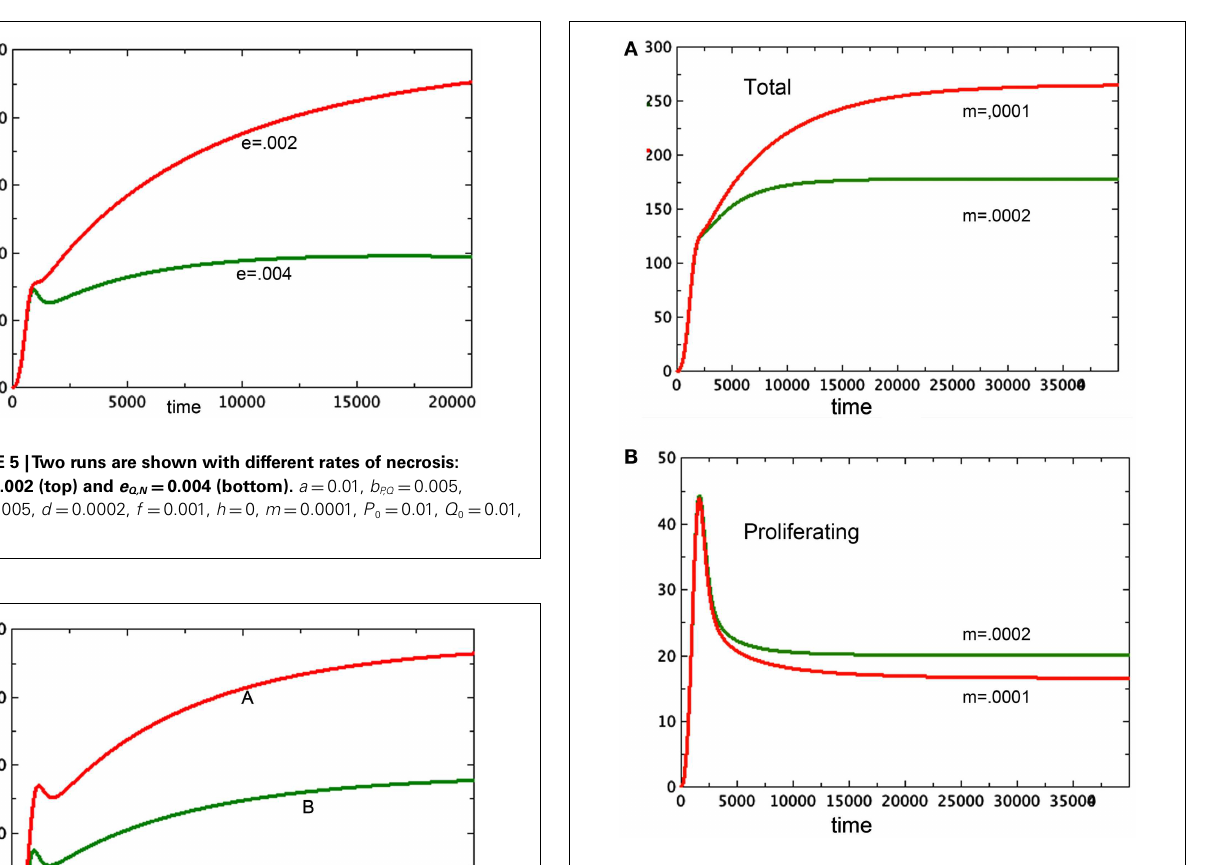
FIGURE 7 | Here we see two graphs of total tumor size in 7A and size of the proliferating pool, 7B. The larger spheroid in 7A has the lower removal rate of N , set at m = 0.0001.The smaller spheroid has m = 0.0002. Note the reversal of size of the proliferating component of the